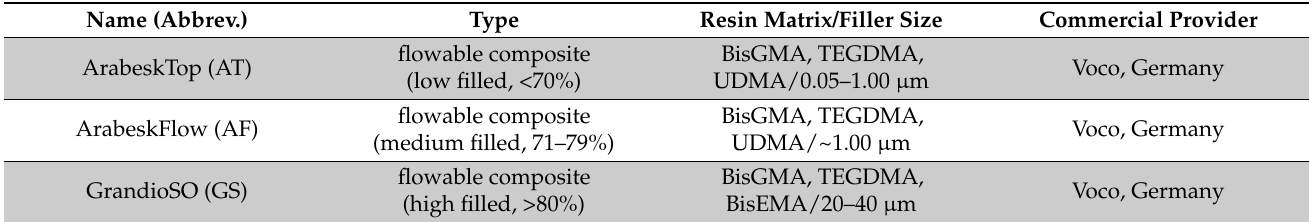
Table 1. Dental-resin composite material used in this